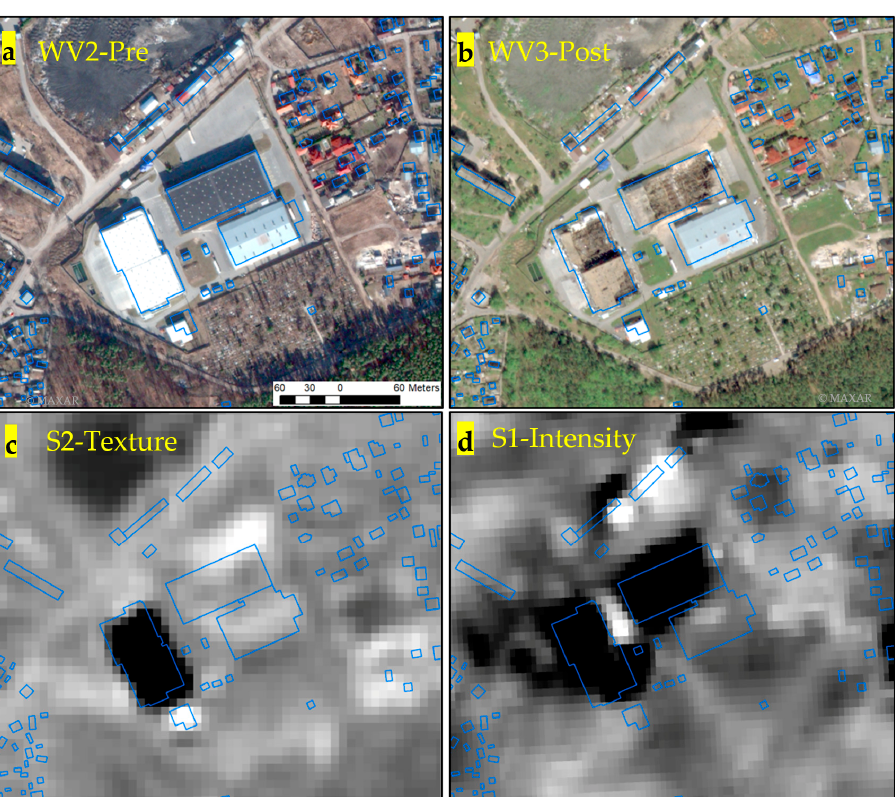
Figure 10. The Sentinel-1 SAR intensity versus Sentinel-2 texture ( c , d ) and the corresponding WorldView imagery taken on 28 February 2022, and 9 May 2022 ( a , b ). The blue polygons are the OSM building footprints overlaid on the images for better comparison.